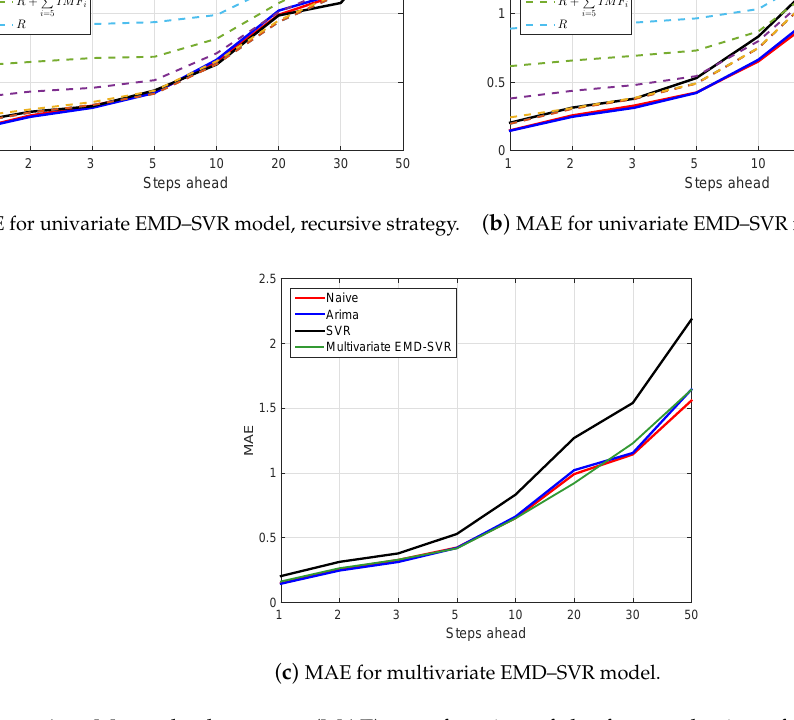
Figure A1. Mean absolute error (MAE) as a function of the forecast horizon for the considered forecasting models: naive, autoregressive integrated moving average (ARIMA ( p , d , q ) ), and univariate and multivariate empirical mode decomposition–support vector regression (EMD–SVR) with input vector m = 1 lagged values.